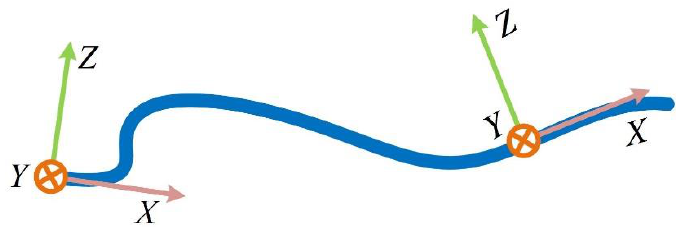
Figure 8. MEMS-IMU and array direction.